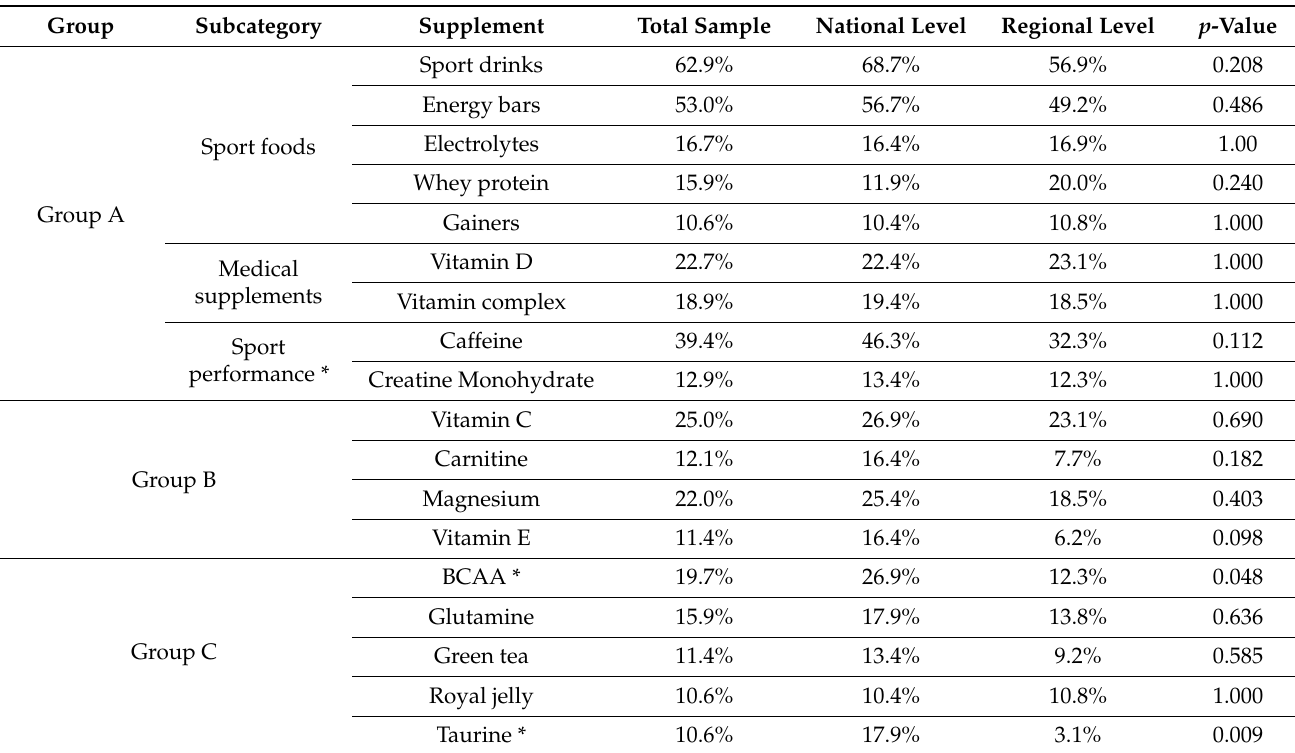
Table 3. SS consumption of national and regional level swimmers in the specific category established by AIS